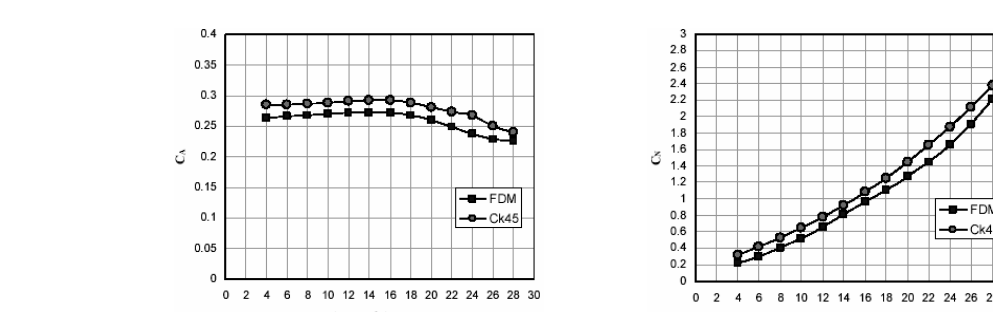
Fig. 3 Comparison of normal force coefficient at Mach 0.3